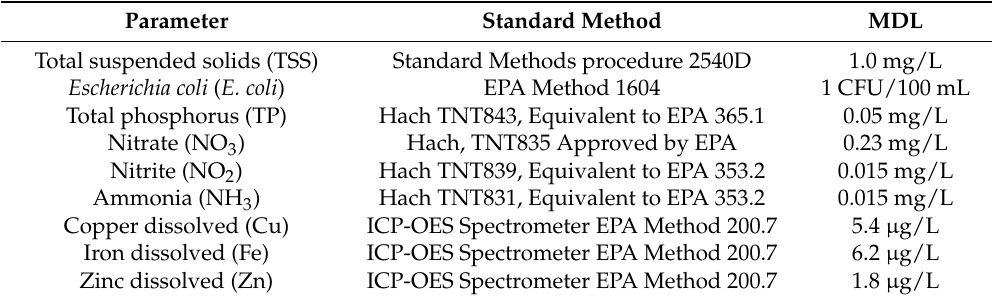
Table 2. Standard test methods and minimum detection levels